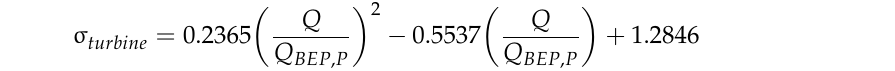
turbine , vs flow rate ratio, Q / Q BEP , T